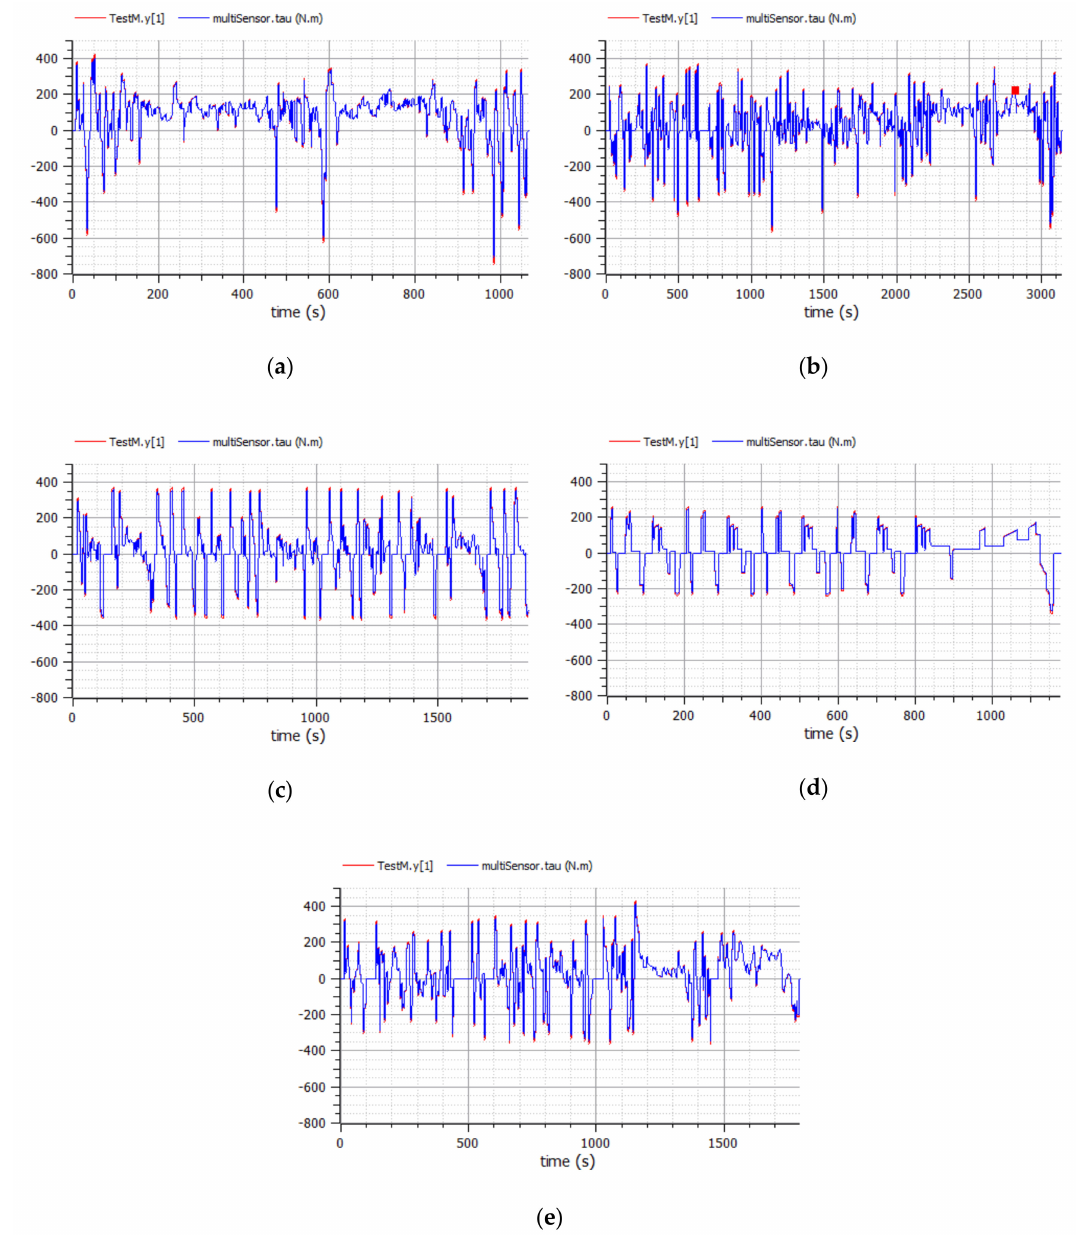
Figure 10. Simulation results of the tested dynamometer brake for the driving test in waveforms of instantaneous values: The required torque for the test—Red line, the torque generated by the tested brake—Blue line: ( a ) CADCM150; ( b ) CADC150; ( c ) FTP75; ( d ) NEDC; ( e )